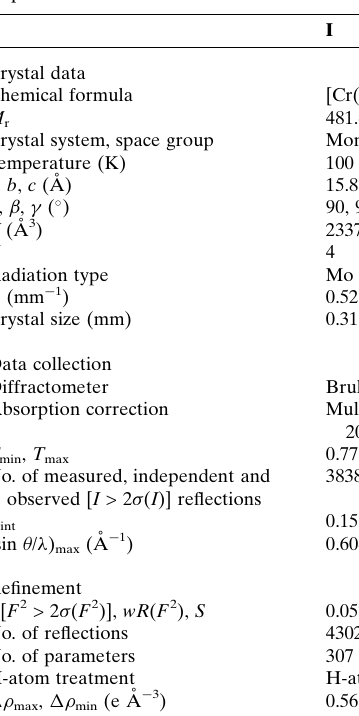
Table 2 Experimental details.